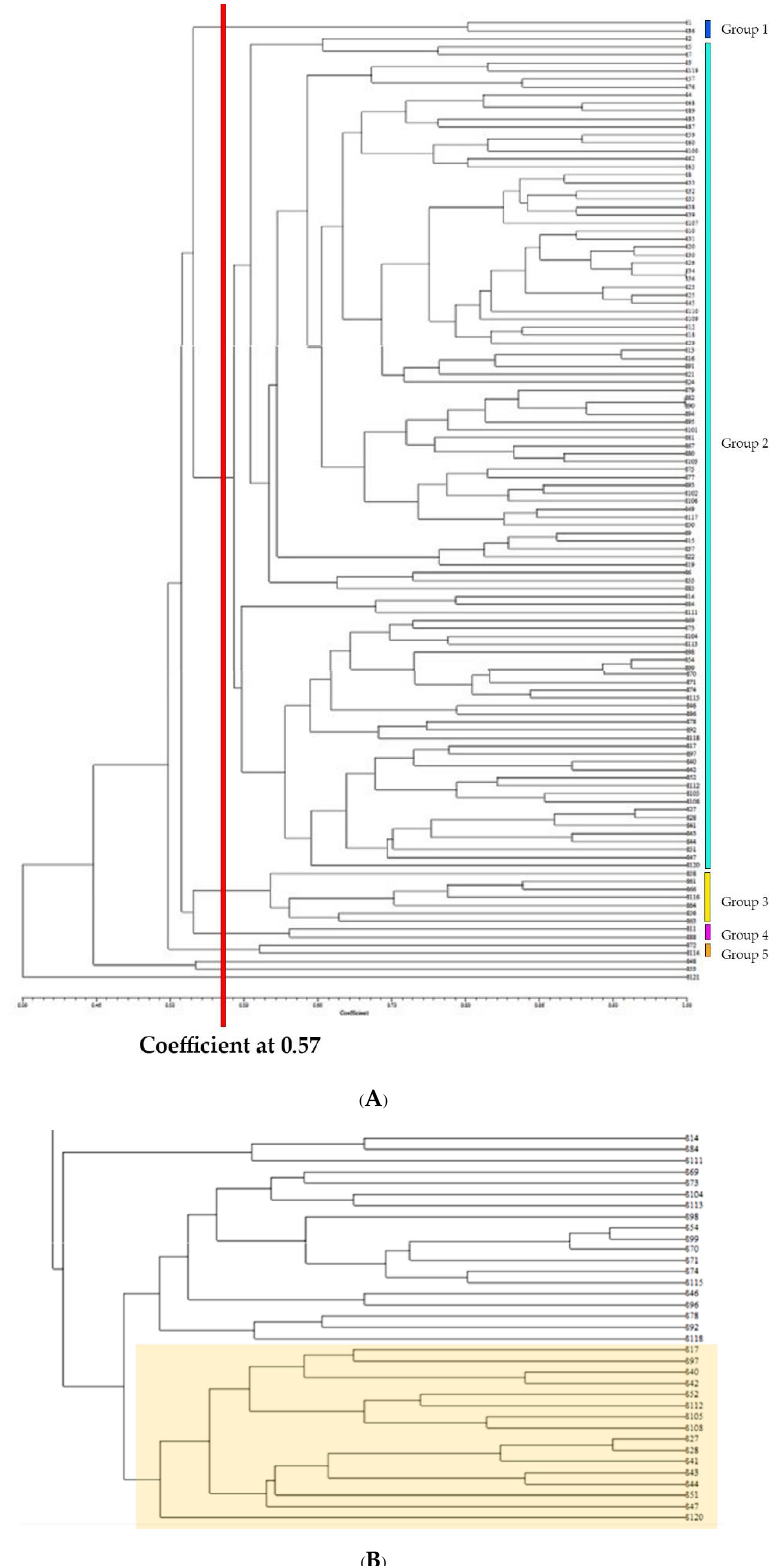
Figure 8. Dendrogram of genetic relationship of oil palm. ( A ). parent samples and ( B ). parent sample with a close relationship with Lam é variety